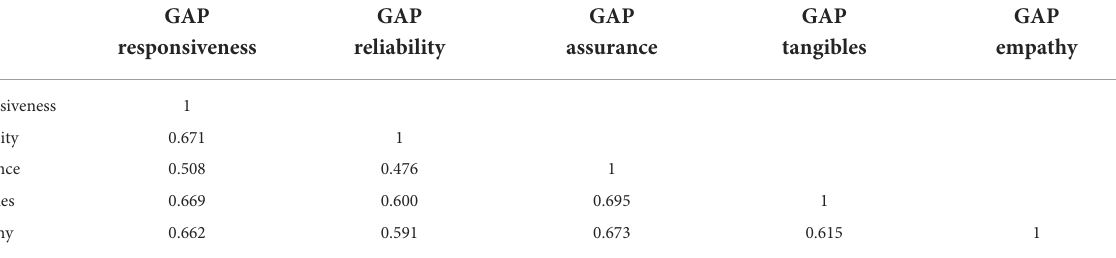
TABLE 7 Correlation between independent variables (GAP) for public